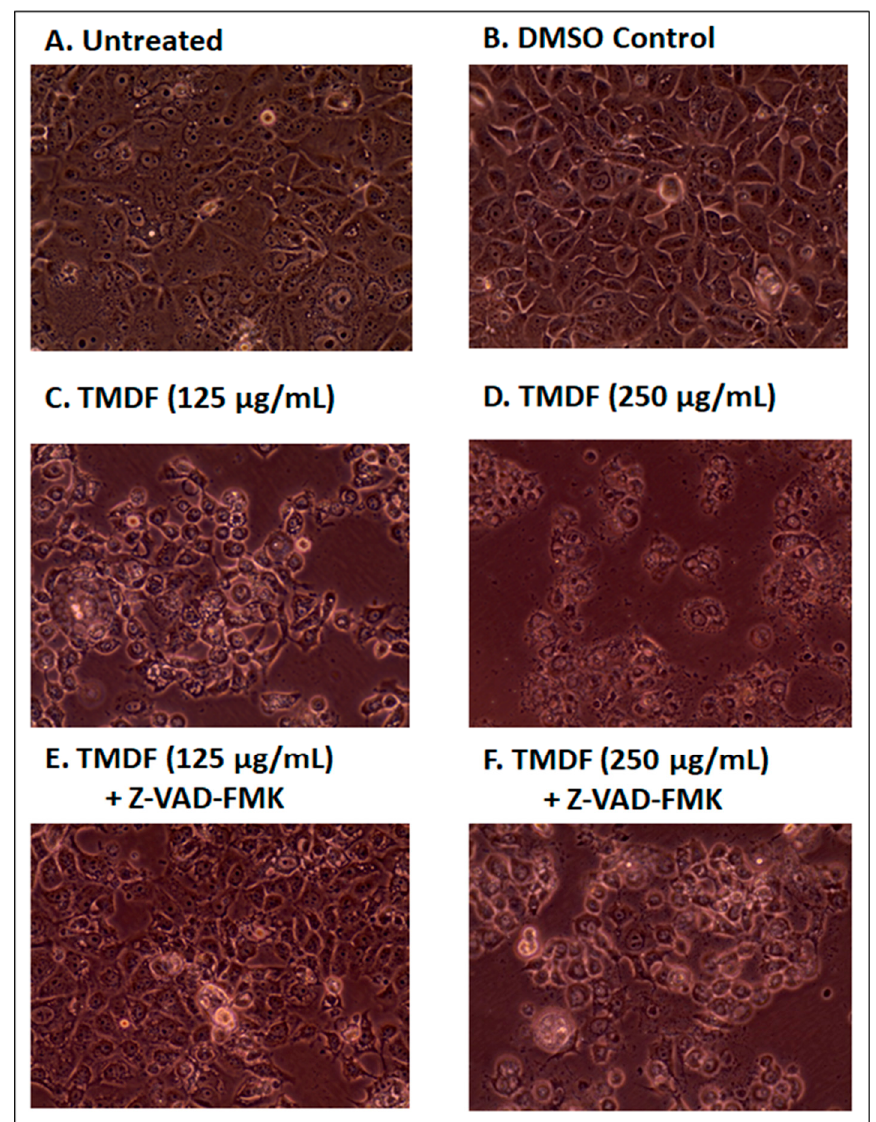
Figure 4. Photomicrographs of MCF-7 cells 24 h after treatment with: ( A ) media alone; ( B ) DMSO; ( C ) 125 µg/mL, and ( D ) 250 µg/mL T. mascatense dichloromethane fraction (TMDF). Panels E and F show